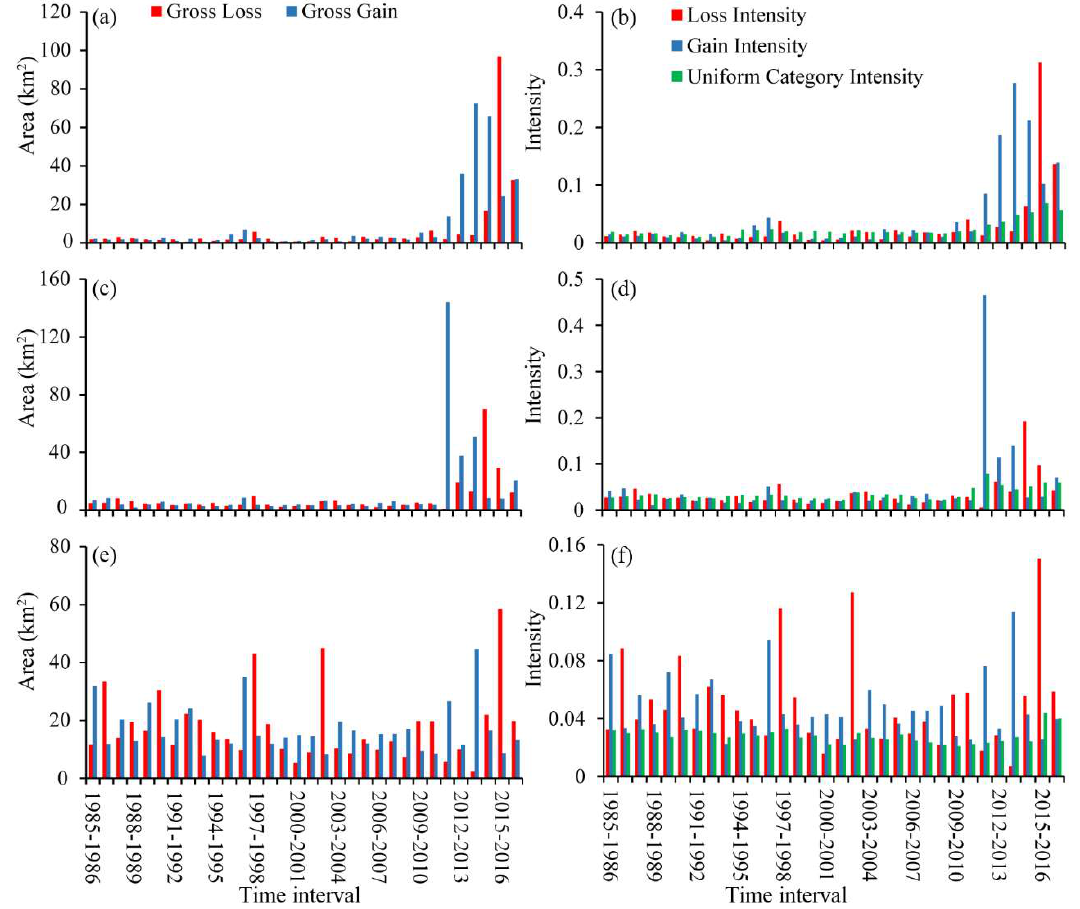
Figure 7. Water gross loss and gain size (left panel) and intensity (right panel) of upstream ( a , b ), midstream ( c , d ), and downstream ( e , f ) regions.